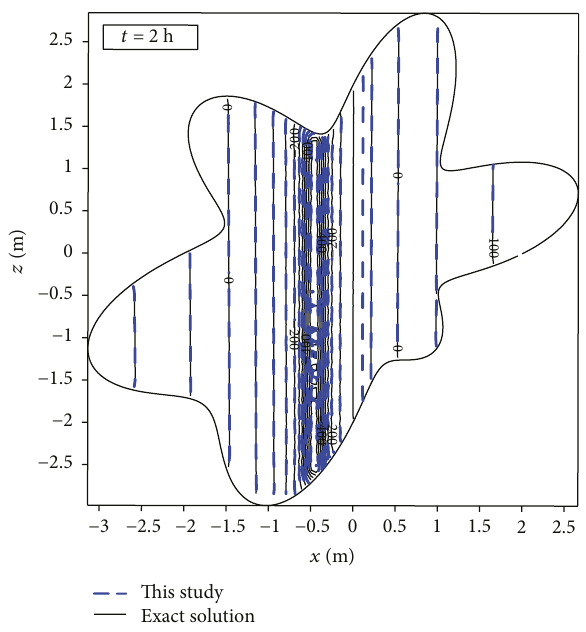
Figure 10: Comparison of computed results with the exact solution for the modeling of two-dimensional transient fl ow in unsaturated soils.